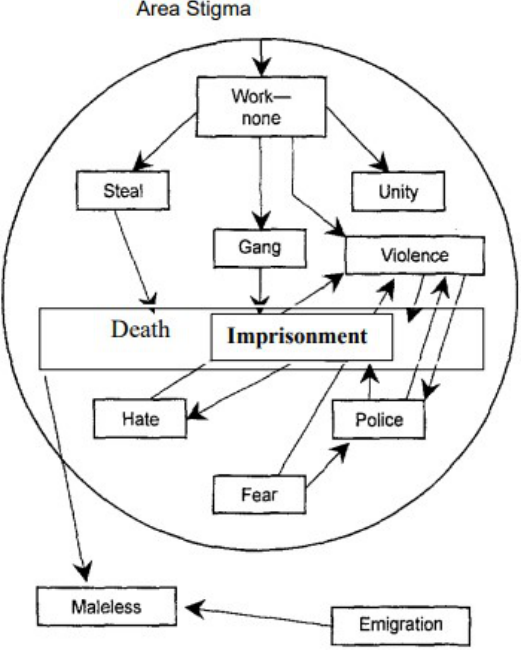
Figure 1. The Problem of Unemployment and Its Impact on Men (Diagram prepared by a group of young men from Park Toms in Kingston, Jamaica) [61]